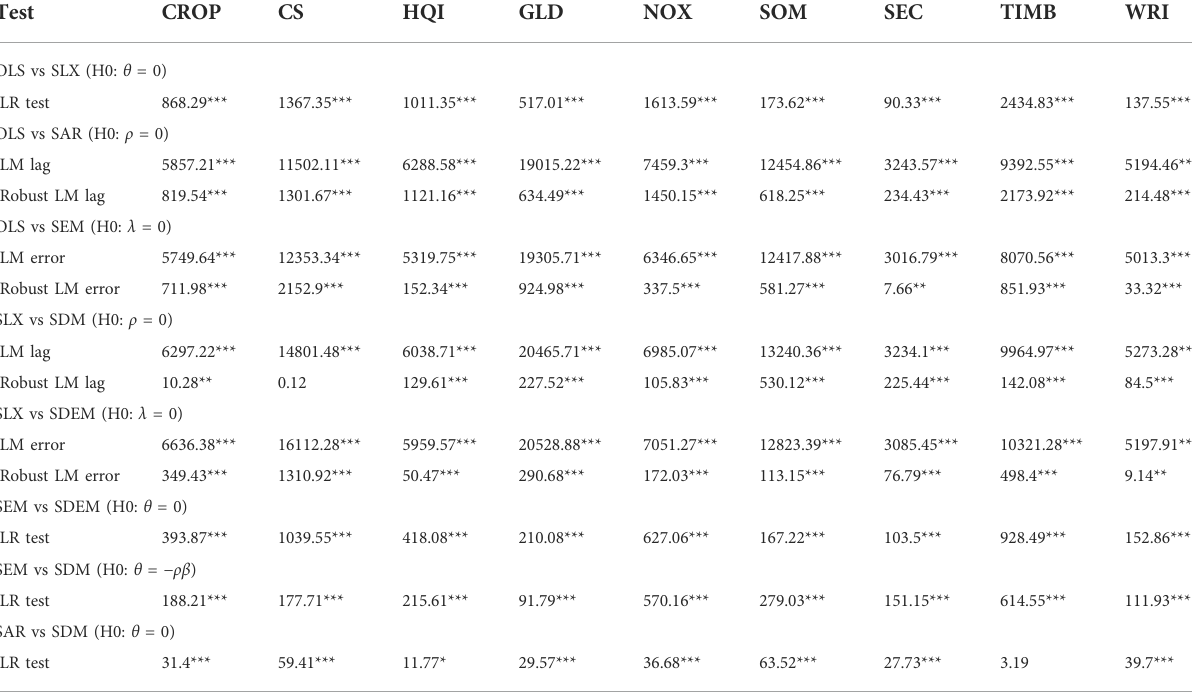
TABLE 3 Statistical tests (likelihood ratio (LR) and Lagrange Multiplier (LM)) between models (rows) per ecosystem service (column). We considered a non-spatial model (OLS), the spatial auto-regressive model (SAR), the spatial cross-regressive model (SLX), the spatial error model (SEM), the spatial Durbin model (SDM), and the spatial Durbin error model (SDEM). CROP stands for crop production; CS for carbon storage; HQI for habitat quality index; GLD for grazing livestock density; NOX for deposition velocity of nitrous oxide; SOM for topsoil organic matter concentration; SEC for soilerosion control;TIMBfortimberremoval;WRIforwaterretentionindex.Itshouldbenotedthatthehypothesis H 0 dependsonwhichmodels are compared. Each value of the statistical tests cannot be interpreted as such; only the signi fi cance of the statistical tests can be so